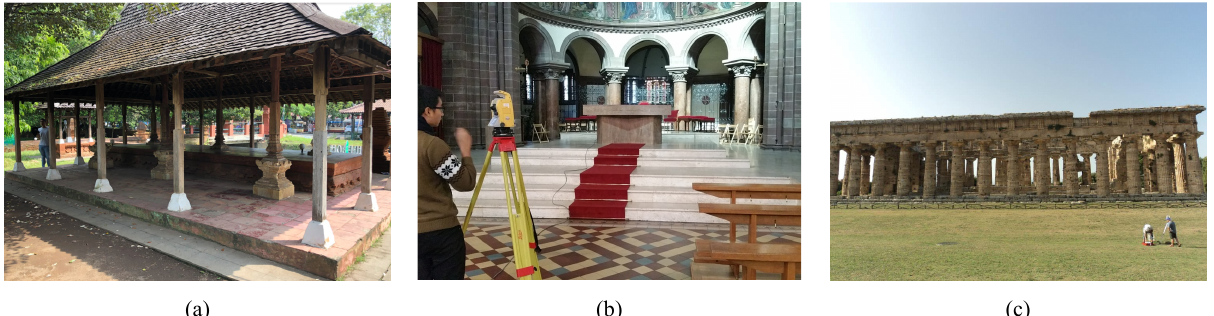
Figure 3. The three cultural heritage sites used as test sites in this paper: (a) the Royal Pavilion of the Kasepuhan Palace in Cirebon, Indonesia; (b) the choir of the Catholic church of St-Pierre-le-Jeune in Strasbourg, France; and (c) the Temple of Hera or colloquially the “Basilica” of the Paestum site in Italy.